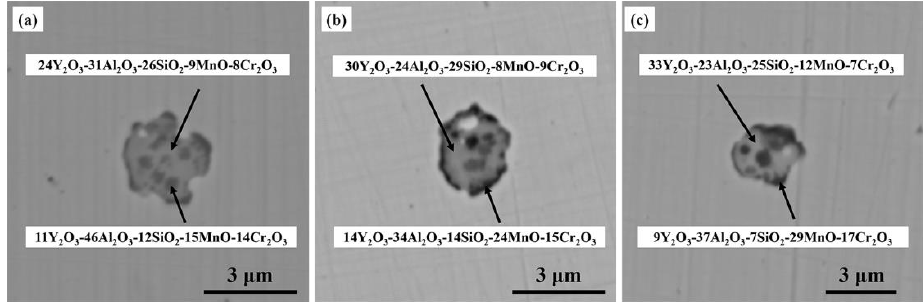
Figure 4. Morphology of typical oxide inclusions in steel #1 after isothermal heating for 0.5 h ( a ), 1.0 h ( b ), and 2.0 h ( c ).